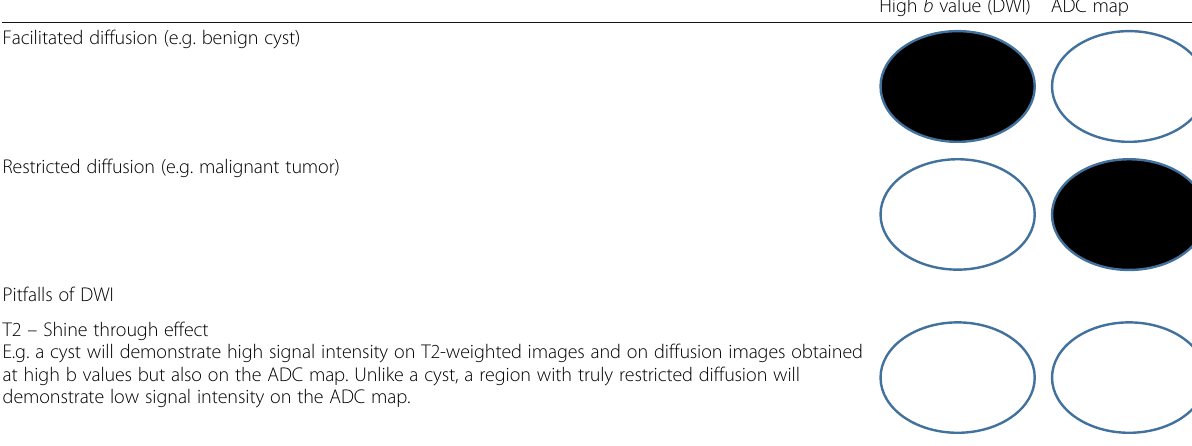
Table 2 Qualitative (Visual) assessment of DW images: signal intensities seen in the high b value images and corresponding ADC maps [7, 8] Facilitated diffusion (e.g. benign cyst)